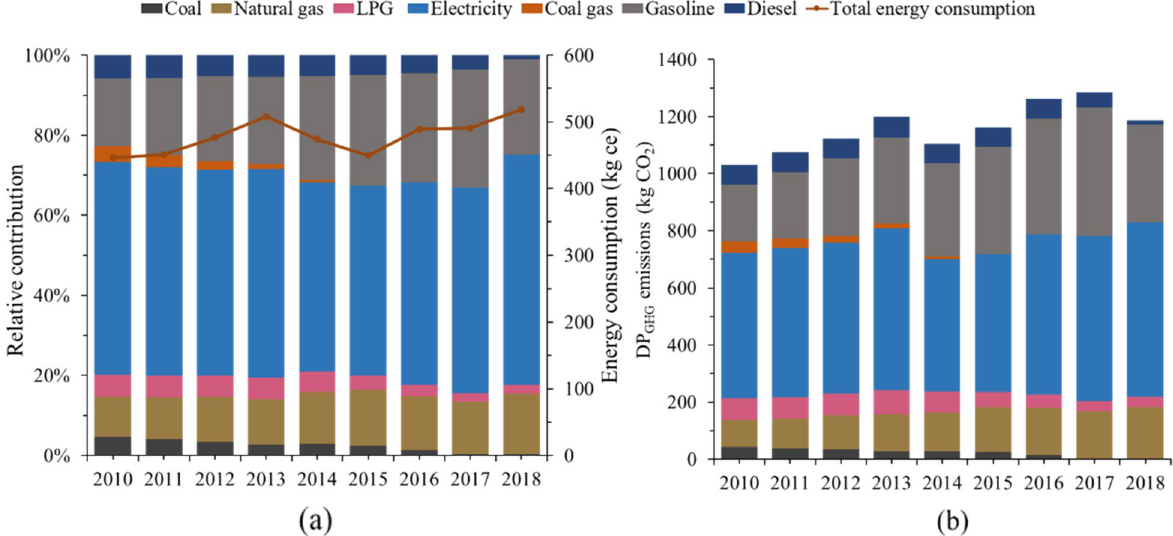
Fig. 3 a The Shanghainese average energy consumption and the proportion of different categories (2010-2018); b The variation of Shanghainese average DP GHG emissions